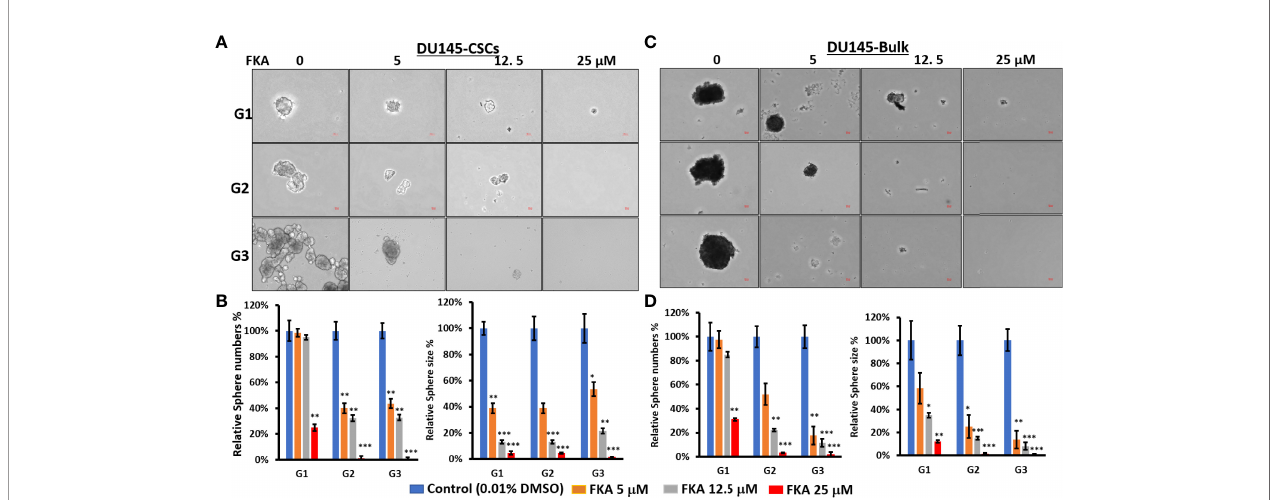
FIGURE 1 | Flavokawain A (FKA) inhibits prostasphere formation. (A) Spheres generated from DU145 cancer stem cells (CSCs) with indicated treatment every 3 days for 14 days at G1 generation and without any treatments at G2 and G3 generations were imaged, and the relative sphere numbers and sizes were analyzed as shown in (B, C) Spheres generated from DU145 bulk cells with indicated treatments every 3 days for 14 days at G1 generation and without any treatments at G2 and G3 generations were imaged, and the relative sphere numbers and sizes were analyzed as shown in (D) . Scale bar: 50 µm. *P<0.5, **P<0.01,